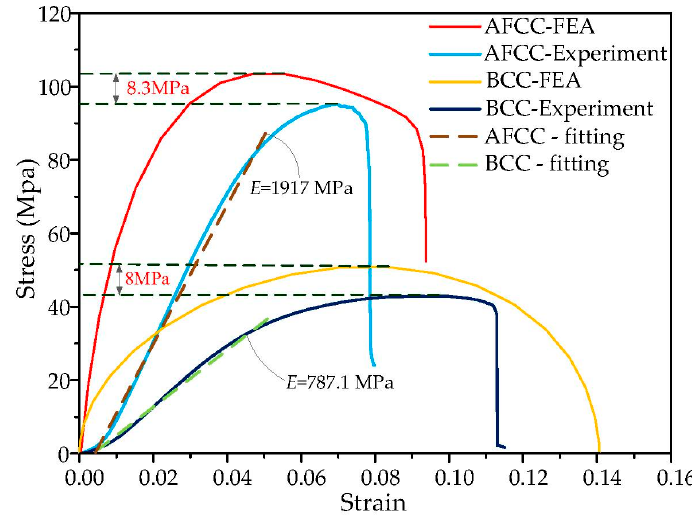
Figure 13. FEA and experimental stress–strain curves and fitting curves of AFCC and BCC lattice structures.